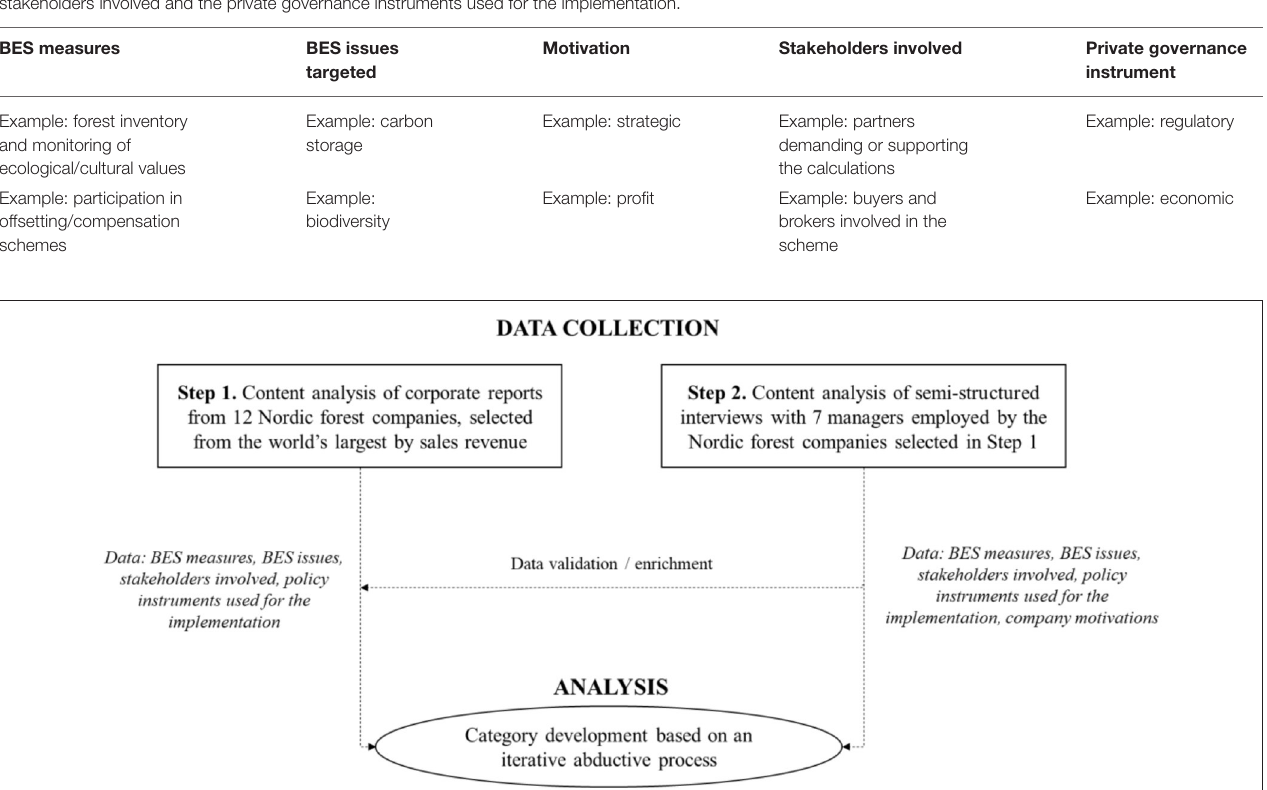
FIGURE 1 | Methodological process employed in this